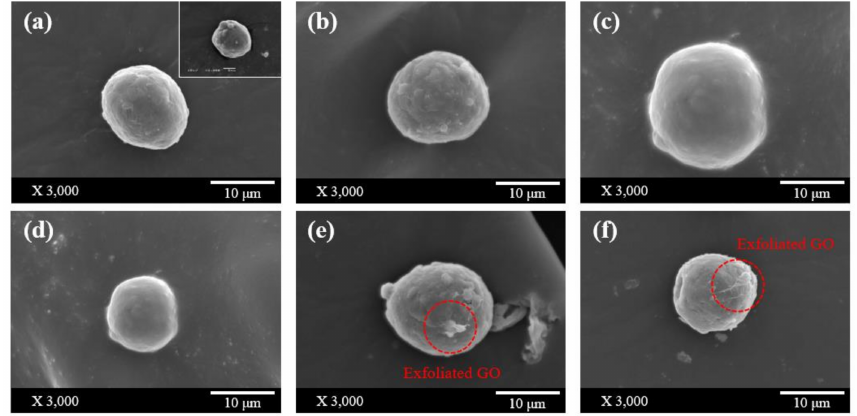
Figure 2. SEM images of ( a ) Al / GO 0.1 wt.% and pristine Al particle (inset image), ( b – f ) Al / GO 0.2 wt.%–0.6 wt.%.